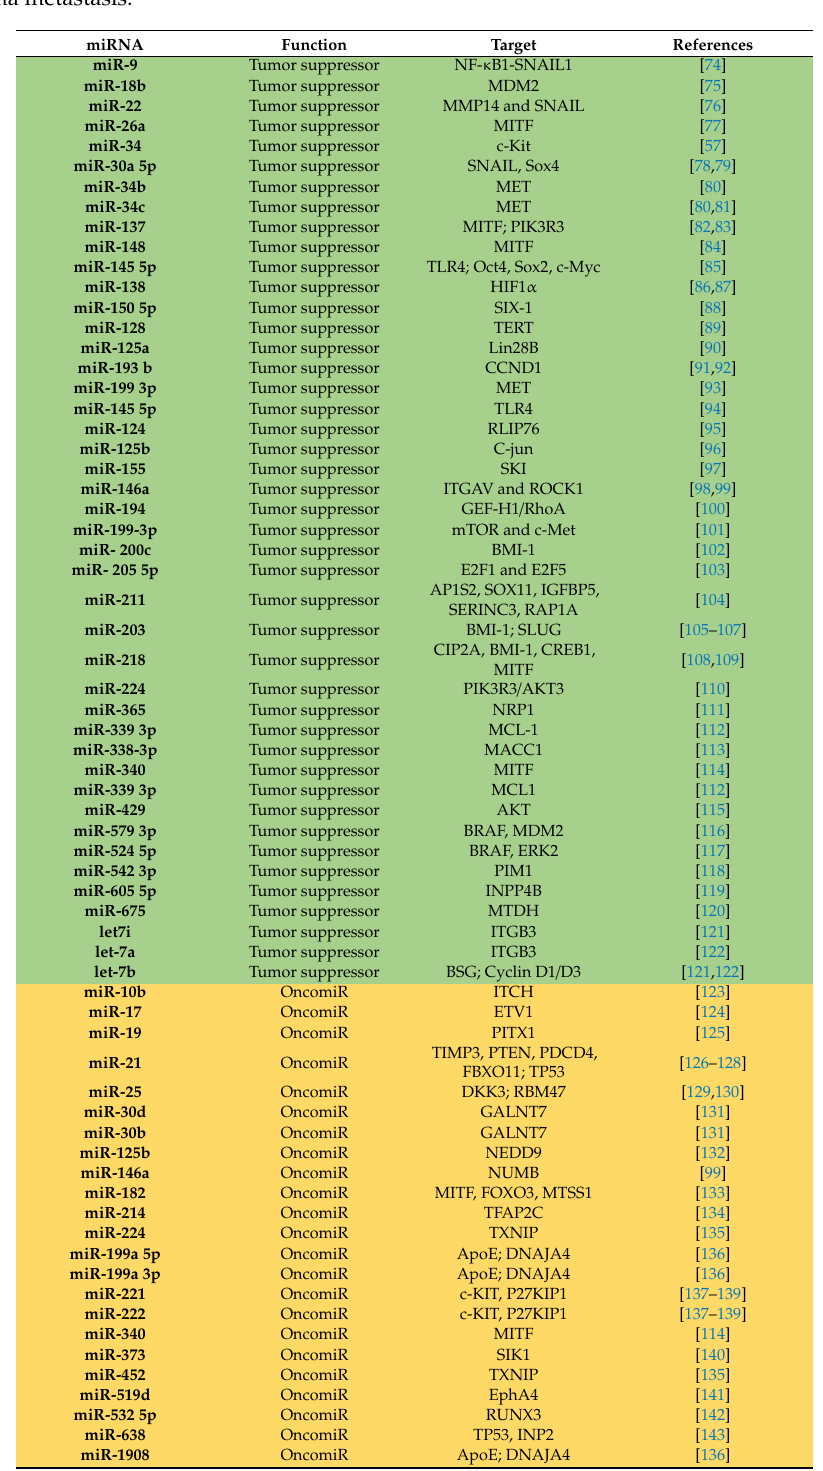
Table 1. Most representative tumor suppressor miRNAs and OncomiR (orange) involved in melanoma